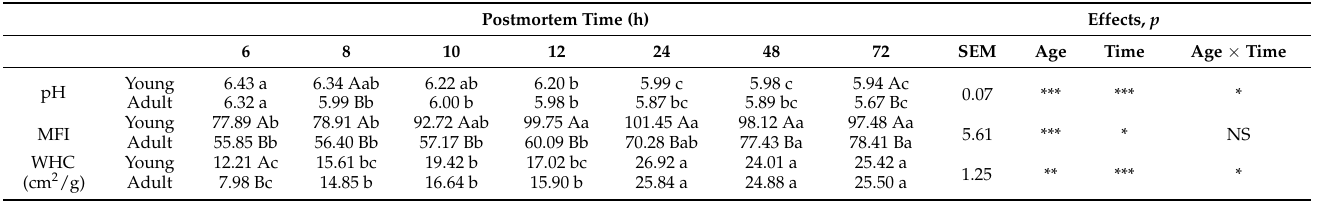
Table 1. pH decline, myofibrillar fragmentation index (MFI) and water-holding capacity (WHC) of the longissimus lumborum (LL) muscles of Sahraoui dromedaries after 6, 8, 10, 12, 24, 48 and 72 h (h) postmortem (means ± SEM), according to slaughter age. Postmortem Time (h) Effects,